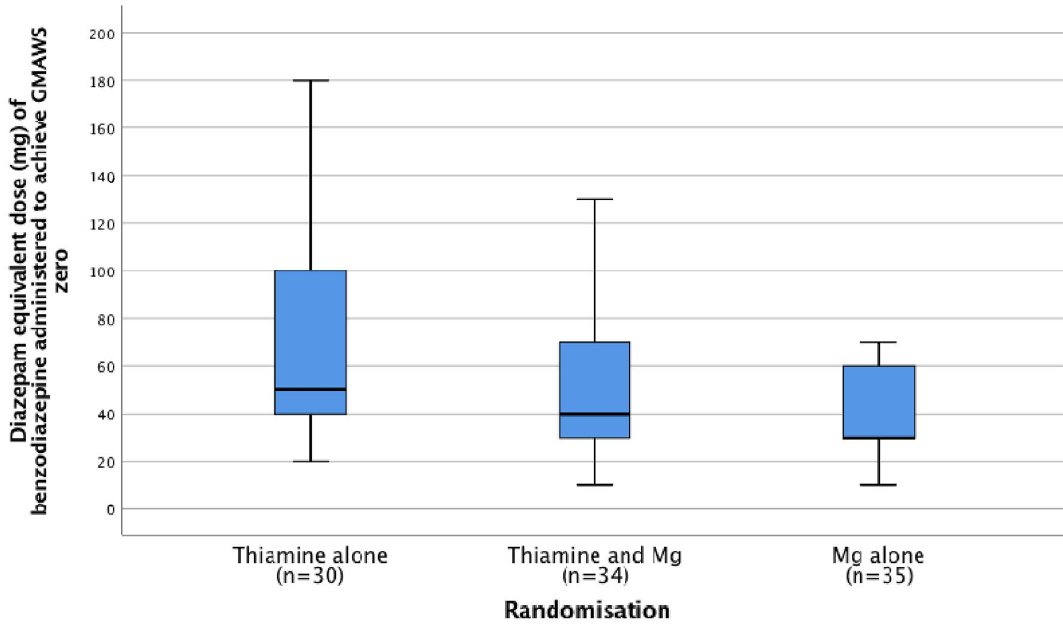
Figure 10. Benzodiazepine (Diazepam equivalent dose) to GMAWS = 0 comparison between groups.